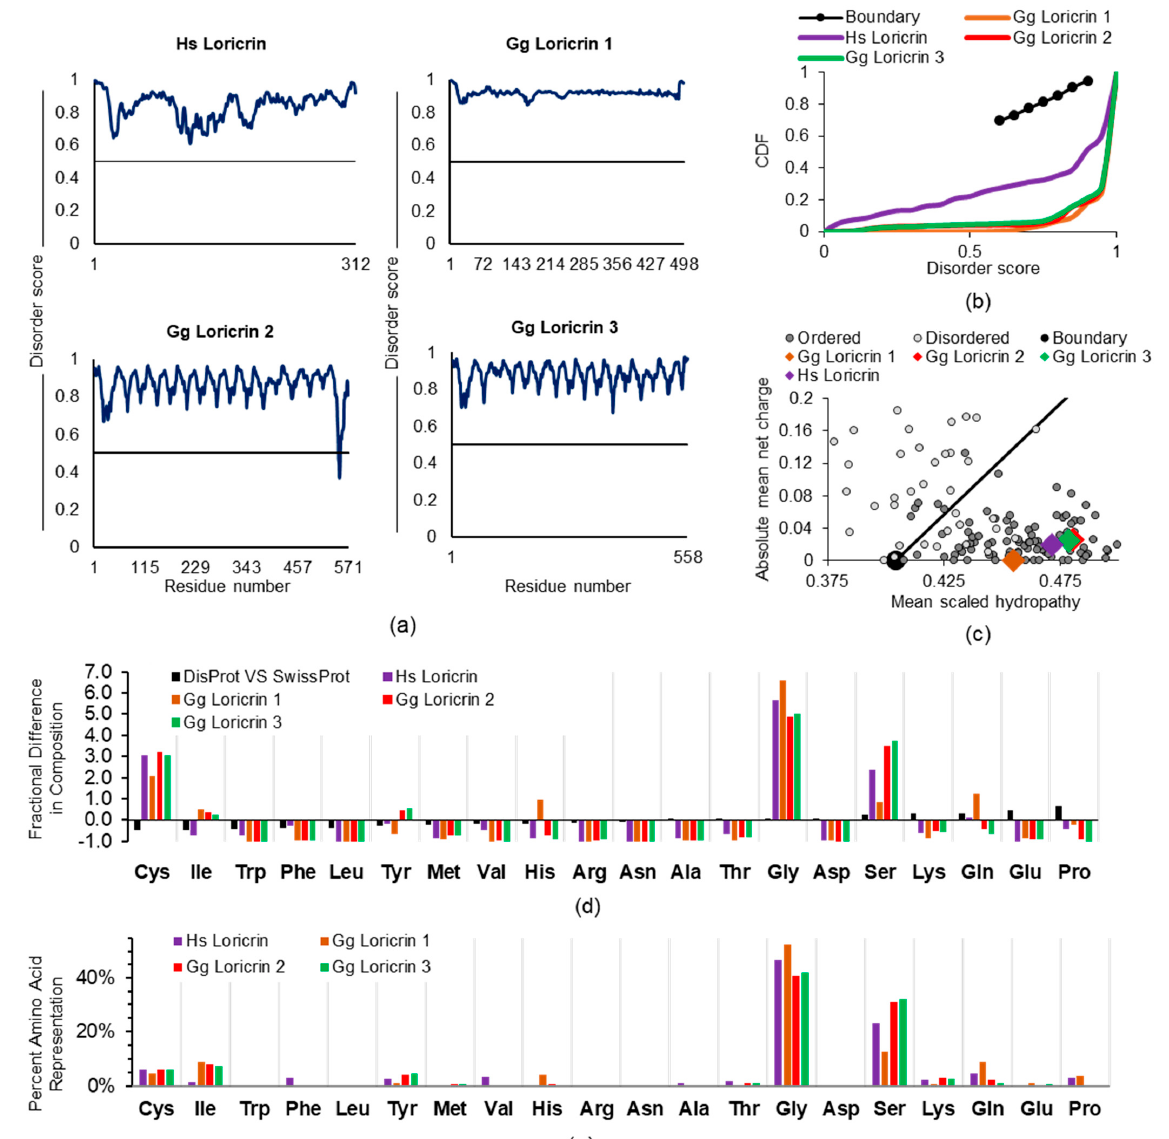
Figure 3. ID analysis of loricrin, a major cornified envelope protein. ( a ) Meta-predictor-driven evidence of intrinsic disorder in human ( Homo sapiens , Hs) and 3 forms of chicken ( Gallus gallus , Gg) loricrin. Boundary line at 0.5 segregates disordered (above 0.5) amino acid residues from ordered (below 0.5). ( b ) Cumulative distribution function (CDF) distinguishes ordered proteins from disordered proteins with increased predicted disorder content driving the plotted points below the boundary (black dotted) line. ( c ) Charge–hydropathy (CH) plot describes intrinsic disorder likelihood by evaluation of absolute mean net charge versus the mean scaled hydropathy of a protein. Ordered standards (light gray circles) and disordered standards (dark circles) provide context for predicted scores of evaluated proteins (various colored diamonds). ( d ) Abundance of amino acids evaluated against those determined for proteins contained in the DisProt database versus the SwissProt database (black bar). ( e ) Amino acid abundancies presented as total percentage of total amino acid content. Coding sequences and expression of the EDC member and CE protein loricrin have been reported across several mammalian and non-mammalian species [43,61]. We find